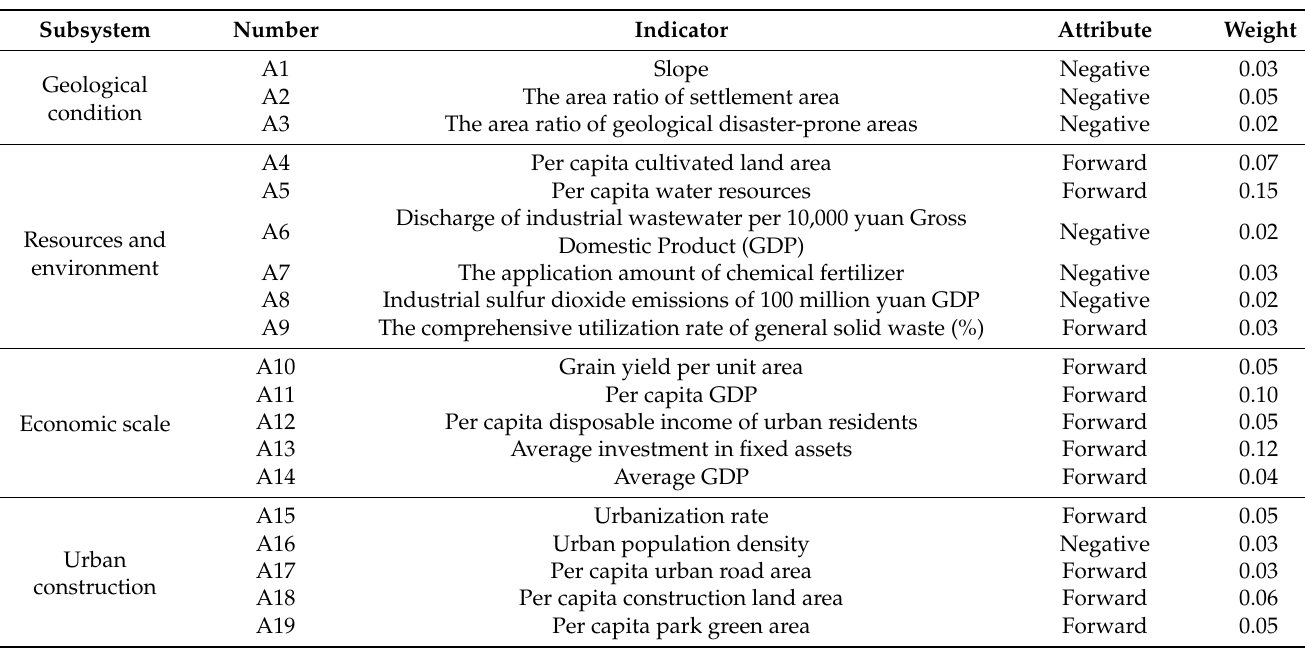
Table 2. Evaluation index system of LCCC in Liaoning Province.